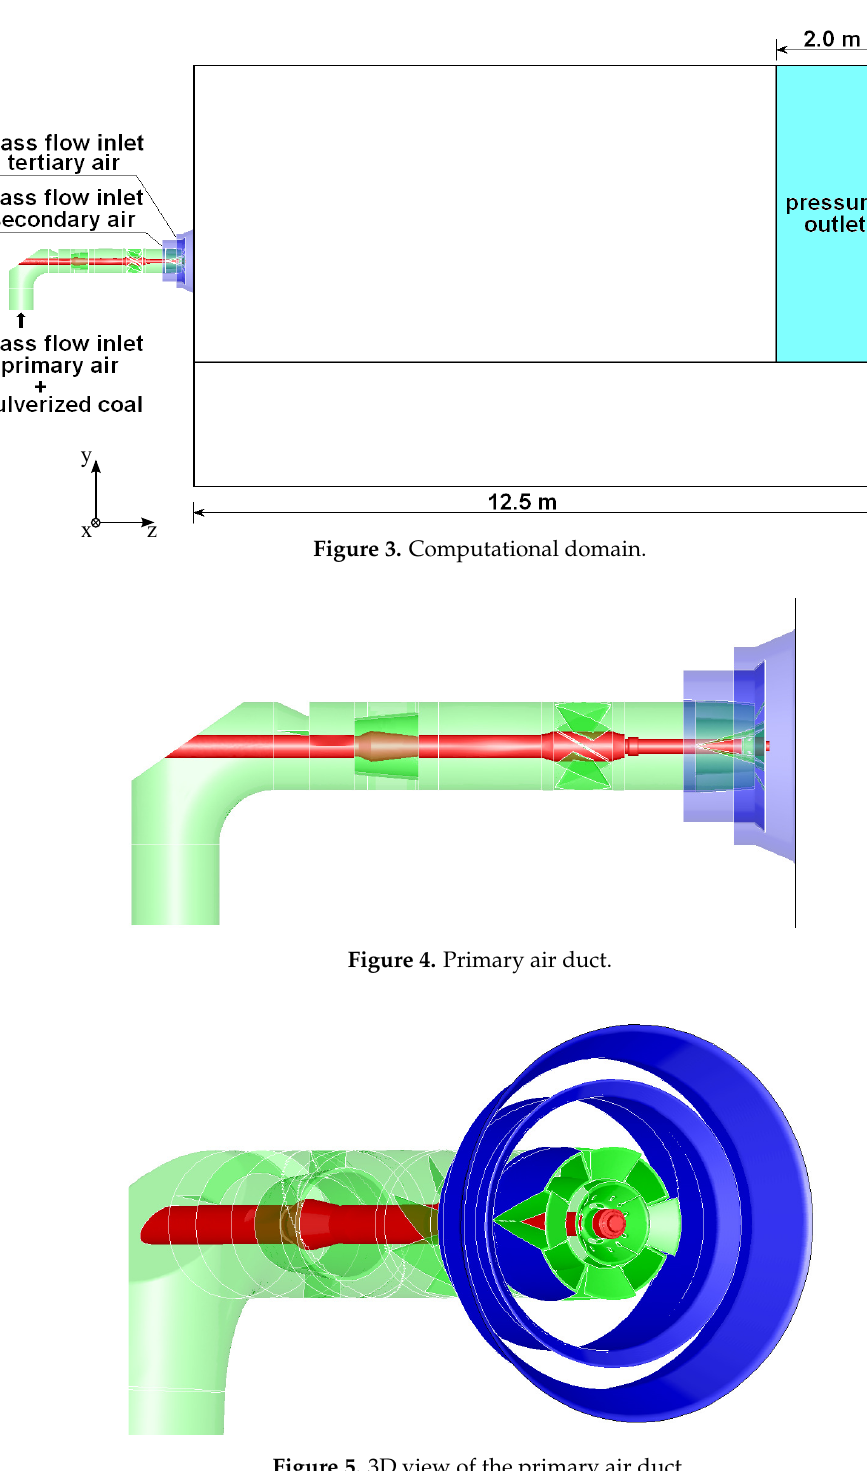
Figure 5. 3D view of the primary air